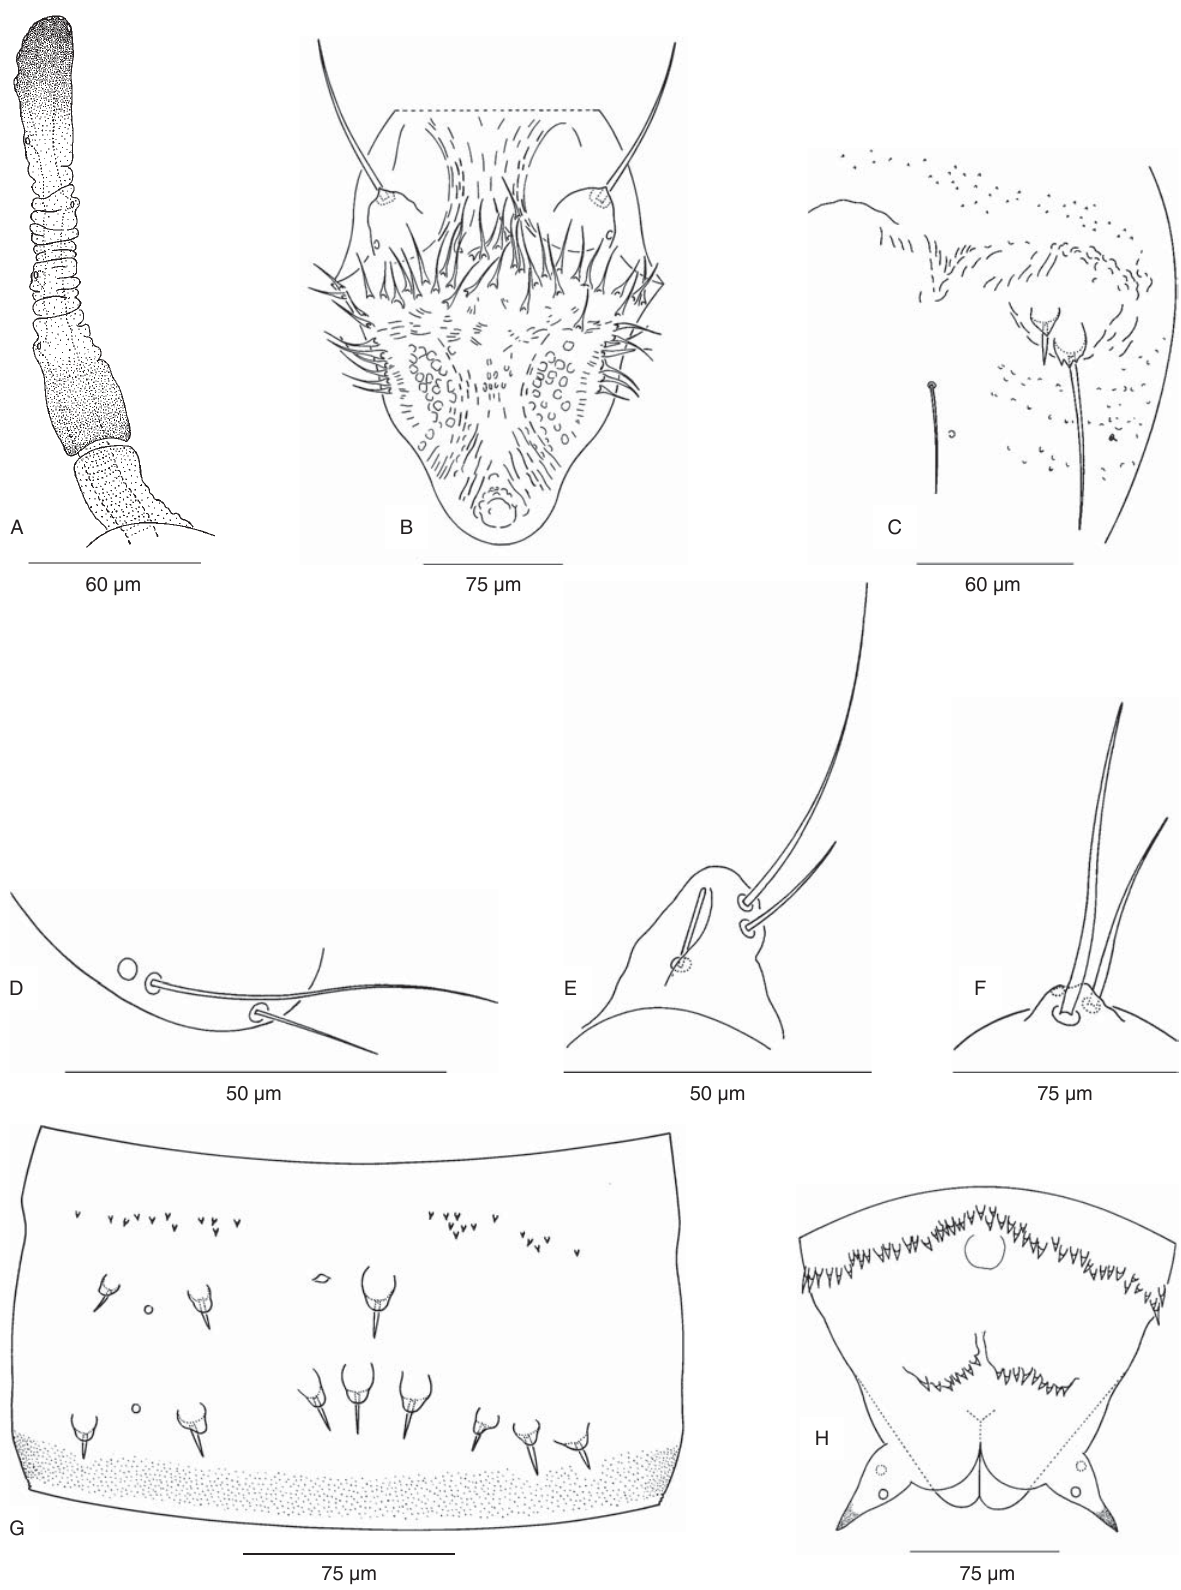
FIG. 1 The pupa of Culicoides imicola : (A) prothoracic respiratory organ; (B) ♀ operculum; (C) thorax; (D) ventrolateral setae (vl); (E) dorsolateral tubercle (dl); (F) anterodorsal tubercle (ad); (G) fourth abdominal segment; (H) caudal